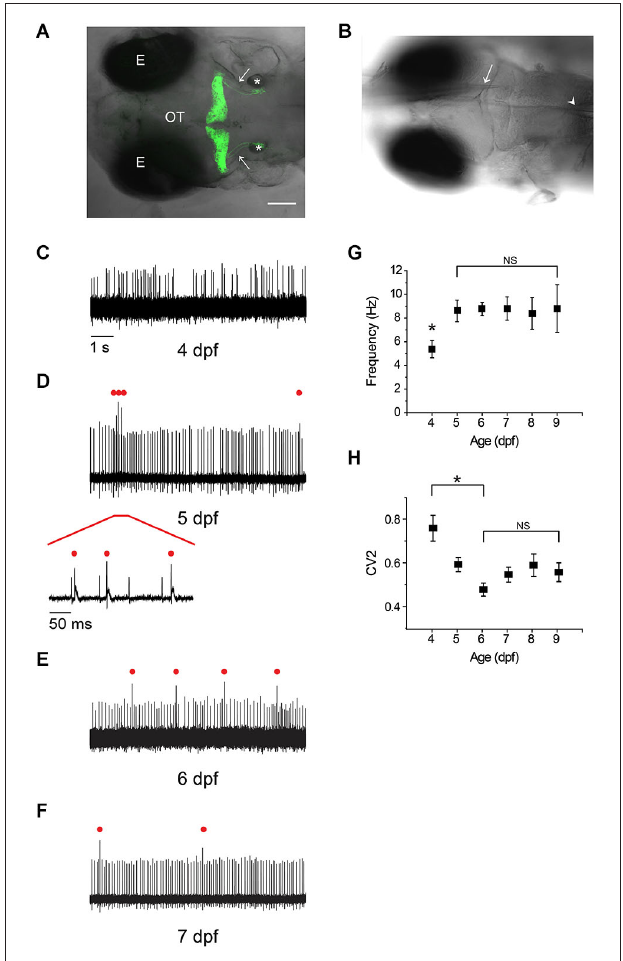
FIGURE 1 | Rapid emergence and maturation of excitability in zebrafish Purkinje cells. (A) Dorsal view of la118Tg: Tg(aldoca:gap43-Venus) transgenic zebrafish at 5 dpf shows that membrane-bound Venus is specifically and exclusively expressed in cerebellar Purkinje cells (Tanabe et al., 2010). Anterior is to the left. A z-projection of 168 1 µ m confocal images has been superimposed on the corresponding bright field image. Images were acquired with an Olympus Fluoview FV300 laser scanning confocal microscope. Labels: E, eye; OT, optic tectum; ∗ , otic vesicle; arrows, cerebellovestibular axon tracts. Scale bar, 100 µ m. (B) The recording configuration is shown. A transgenic zebrafish at 5 dpf has been fixed in the recording chamber. A loose-patch electrode (arrow) was inserted from the anterior side and advanced to contact the cell body of a Purkinje cell. In some experiments, a theta pipette (arrowhead) was placed in the inferior olive to stimulate climbing fibers. (C–F) Shown are representative loose-patch recordings acquired at (C) 4 dpf, (D) 5 dpf, (E) 6 dpf, and (F) 7 dpf. In (D) , red bar marks portion of trace that is shown on an expanded time scale below the main trace. In (D) , (E) , and (F) , complex spike-like events are indicated by red dots. (G) The average simple spike firing frequency has been plotted vs. age ( n = 7–31 cells from 6–24 animals). The frequency at 4 dpf, 5.4 Hz, was significantly different from the frequency on all subsequent days, which averaged ∼ 9 Hz ( ∗ , ANOVA: 4–9 dpf, F ( 5,113 ) = 2.41, p = 0.04, followed by Tukey’s post hoc test: 4 and 5 dpf, p < 0.05). Values obtained between 5 and 9 dpf did not differ significantly (NS, ANOVA: 4–9 dpf, F ( 5,113 ) = 2.41,